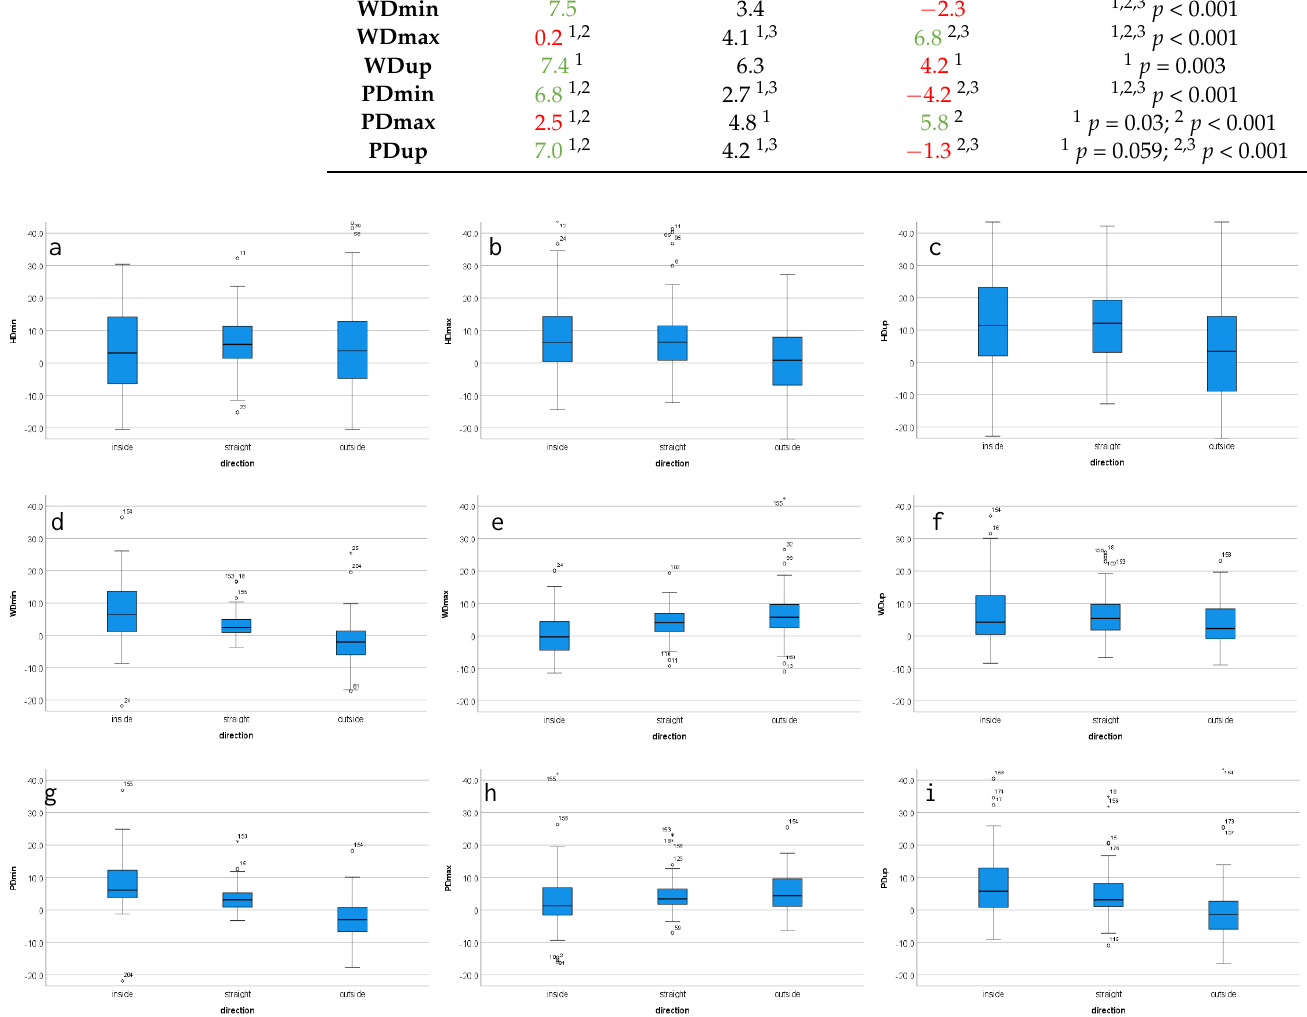
Figure 2. Normalized movement asymmetry values (in mm) for N = 30 reining QHs as a function of movement direction for trot on reining type arena surfaces during in-hand and ridden exercise for straight-line and circular movement. Positive asymmetry values indicate movement asymmetry in the direction of the measured baseline asymmetry, negative values indicate movement asymmetry opposite in direction to the measured baseline asymmetry. ( a ) HDmin, ( b ) HDmax, ( c ) HDup, ( d ) WDmin, ( e ) WDmax, ( f ) WDup, ( g ) PDmin, ( h ) PDmax, ( i ) PDup. Outliers ‘°’ defined as data points more extreme than first quartile – 1.5 times interquartile range or more extreme than third quartile + 1.5 times interquartile range. Extreme outliers ‘*’ defined as data points more extreme than first quartile – 3 times interquartile range or more extreme than third quartile + 3 times interquartile range. Table 4. Estimated marginal mean (EMM) values for fixed factor movement direction (DIR) for the seven affected asymmetry parameters. All values in mm. Values marked with same index have pairwise significant difference (Bonferroni). The highest value for each asymmetry parameter is given in green, the lowest value in red.